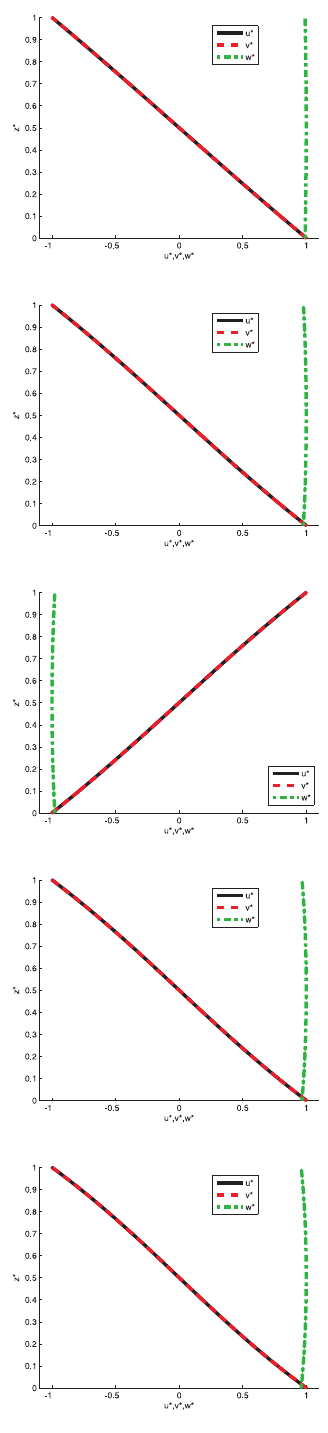
shell, the FE code gives a frequency with w=0 for half- wave numbers (4,0). This frequency is also obtained by the